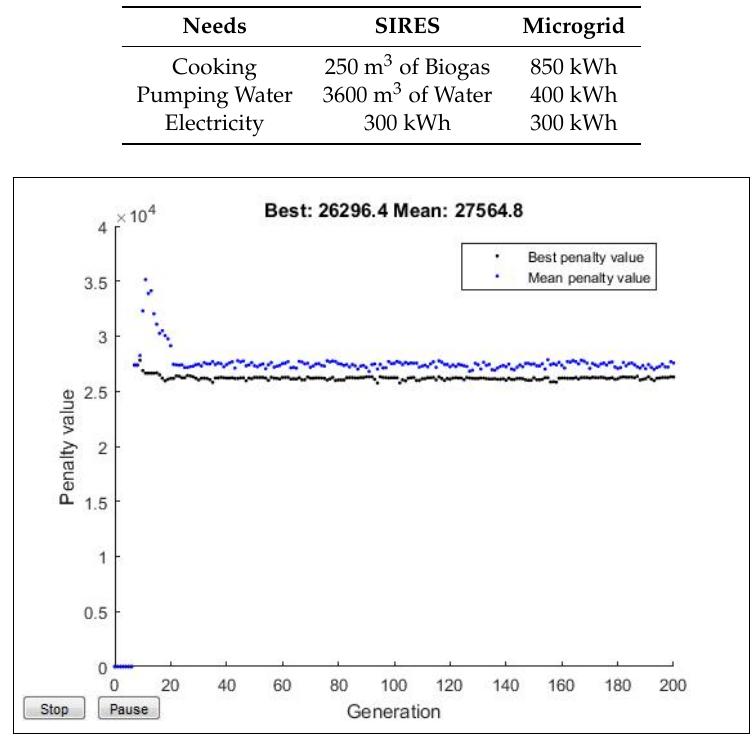
Table 6. Needs fulfilled by SIRES converted to Electricity.